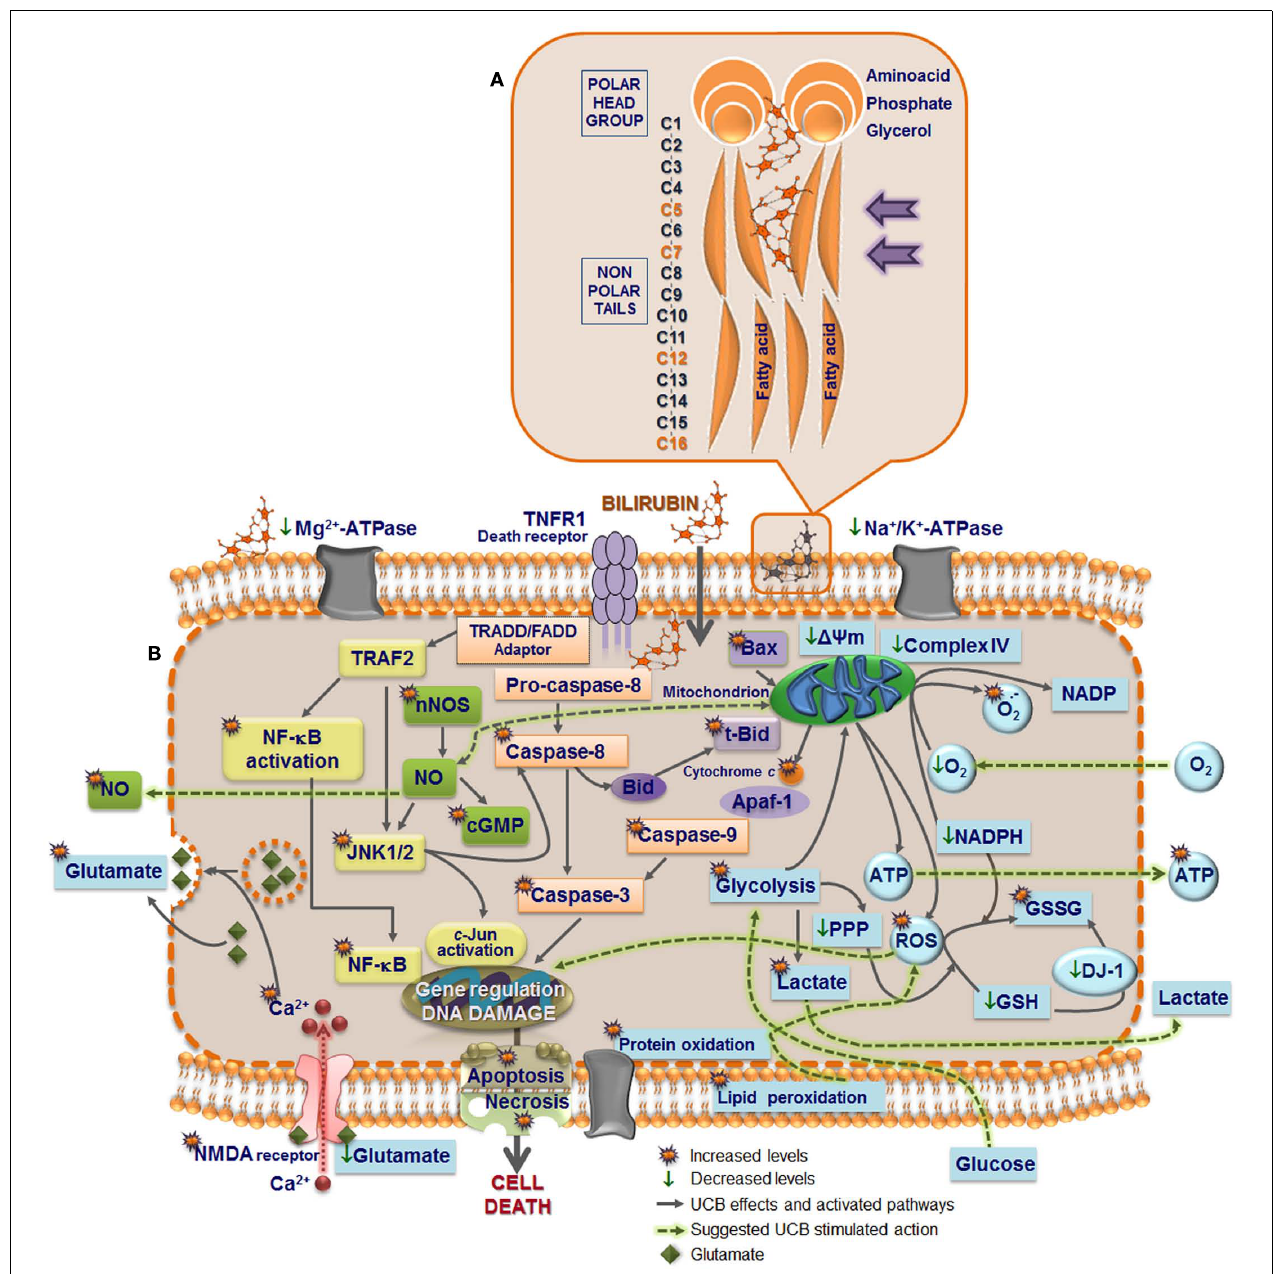
reactive oxygen species (ROS) production. UCB impairs Mg 2 + -ATPase activity, responsible for the maintenance of phosphatidylserine in the inner leaflet, and Na + , K + -ATPase, which may trigger the intracellular intrusion of calcium (Ca 2 + ). Opening of Ca 2 + channels, as well as the activation of NMDA receptors by UCB, recognized to modulate the exocytosis of glutamate, can also account to it. Changes in membrane polarity and fluidity, equally produced at the mitochondrial membrane by UCB, lead to the collapse in the mitochondrial transmembrane potential ( ΔΨ m), translocation of proapoptic Bax to the mitochondria, inhibition of cytochrome c oxidase activity (complex IV of the respiratory chain), and efflux of cytochrome c .Then, activation of caspases 3 and 9 (intrinsic apoptotic cascade) takes place, as well as UCB-induced